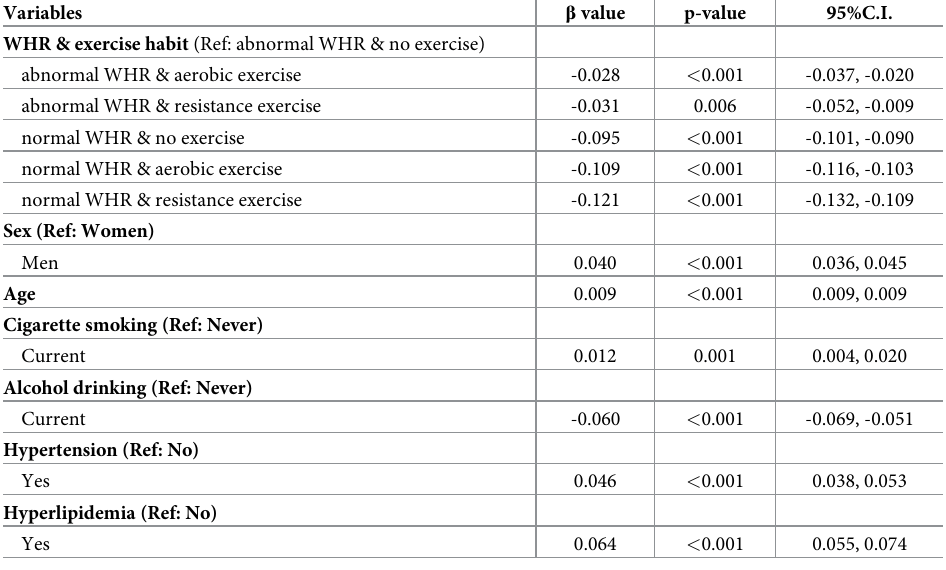
Table 4. Association between HbA1c and different combinations of WHR and exercise using multivariate analyses. Variables β value p-value